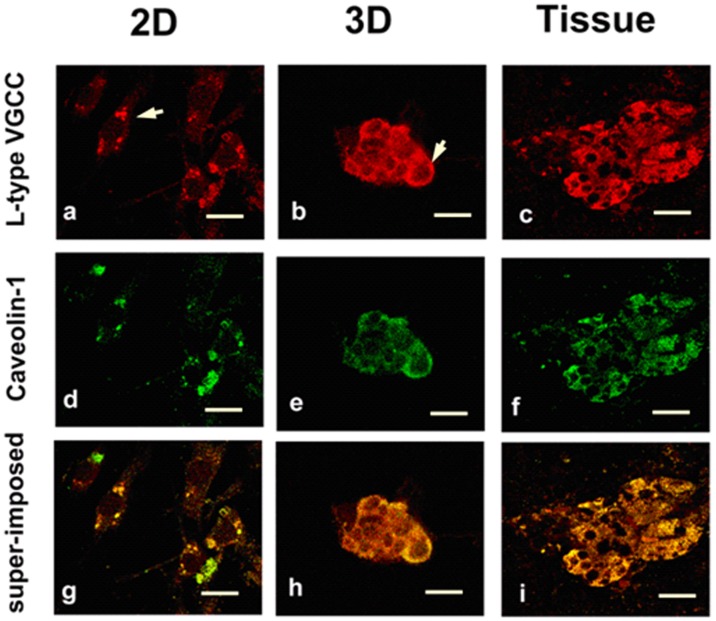
L-type VGCC and caveolin-1 colocalization.(a)–(c) Confocal images of L-type calcium channel staining of SCG cells cultured on 2D surface (a), 3D scaffolds (b) and in freshly dissected SCG tissue (c). Arrows point to one cell. (d)–(f) Confocal images of caveolin-1 (caveolar protein) from SCG cells cultured on 2D surface (d), 3D scaffolds (e) and in freshly dissected SCG tissue (f). (g)–(i) are the super-imposed image of VGCC and caveolin-1 staining, yellow indicates that VGCC protein and caveolin-1 are colocalized. Scale bars are 20 µm.